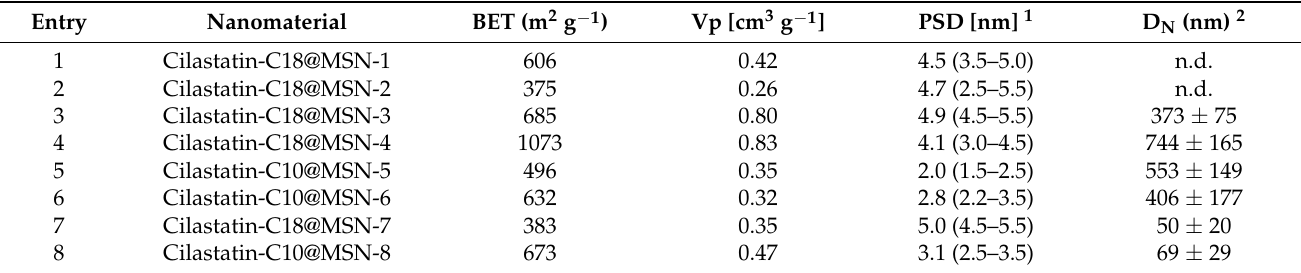
Table 2. Mesoporous silica nanoparticles textural properties of cilastatin-C10@MSNs and